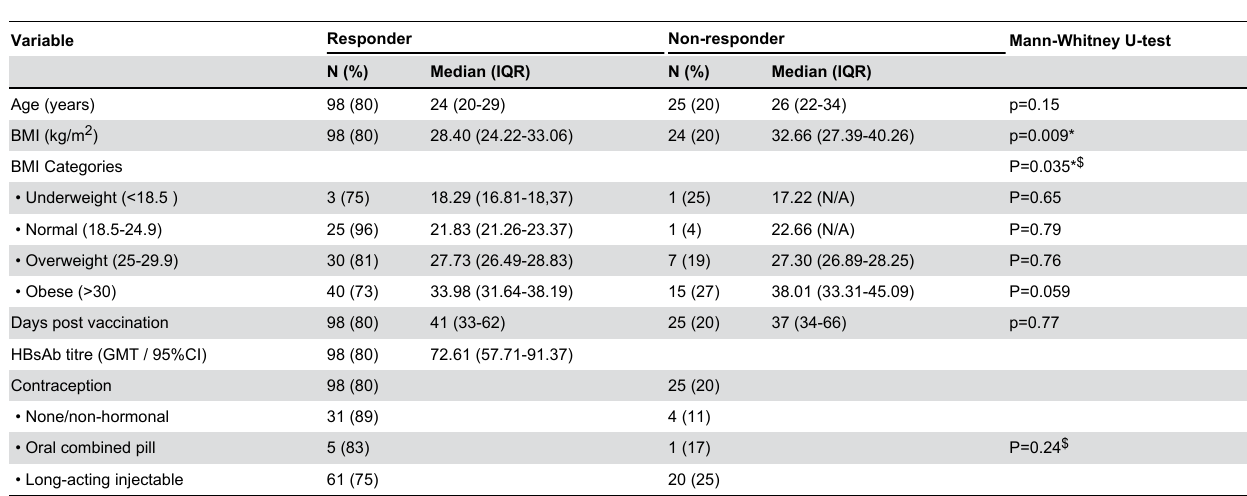
Table 1. Summary statistics by response